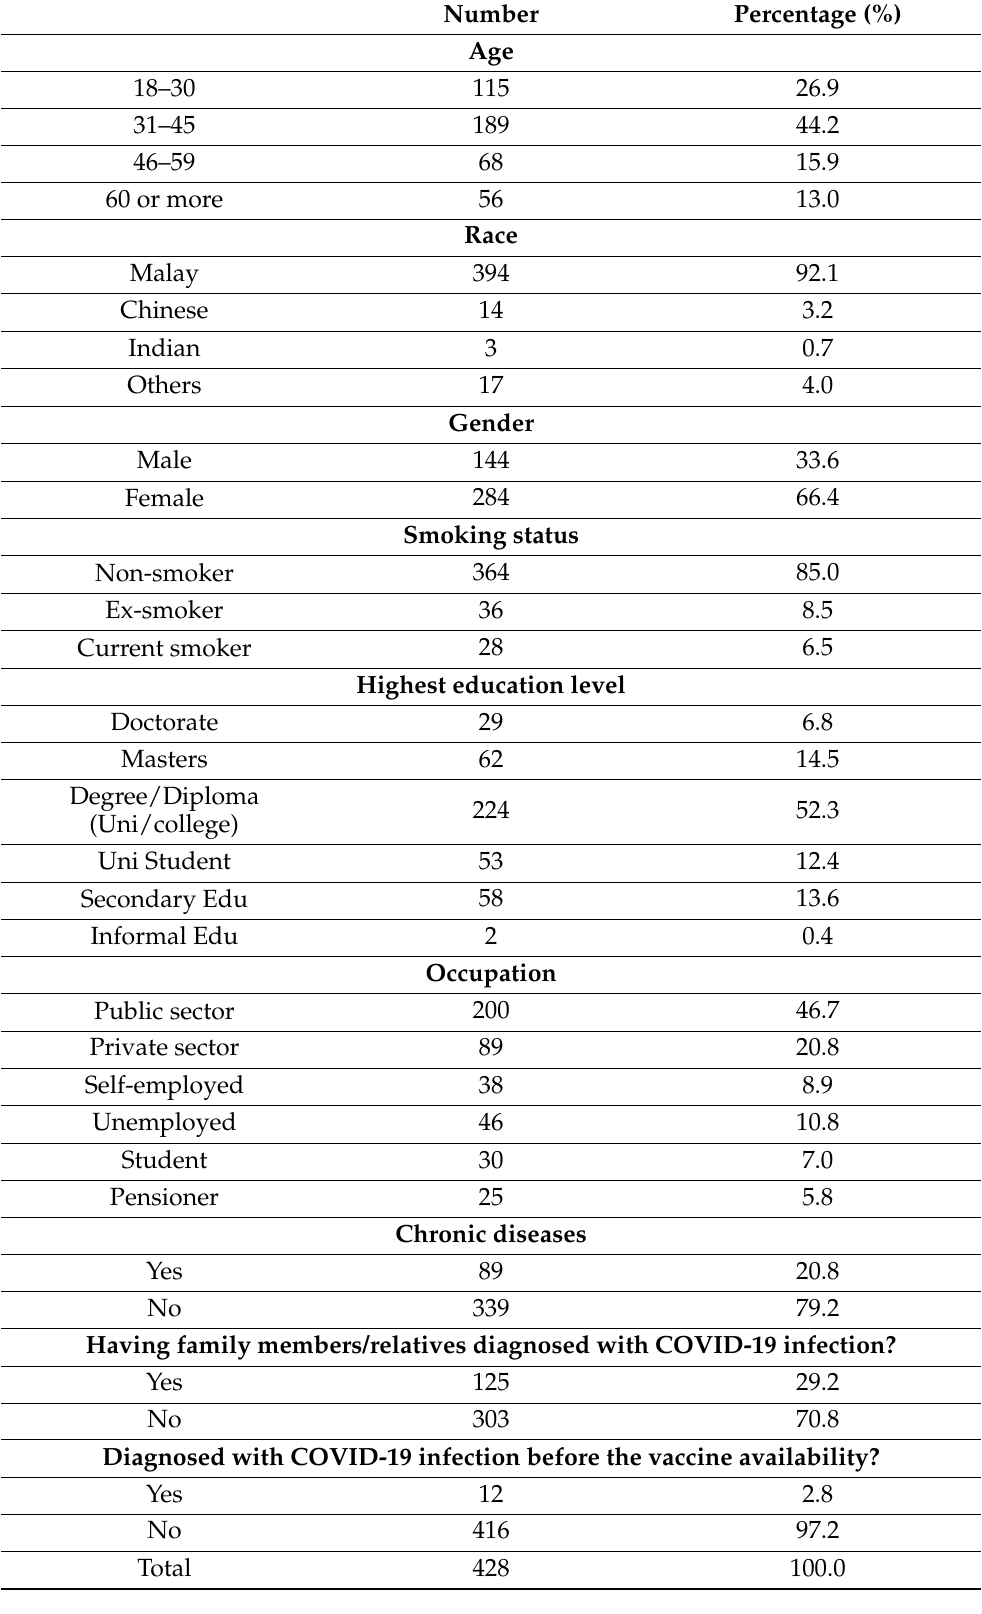
Table 1. General information of study